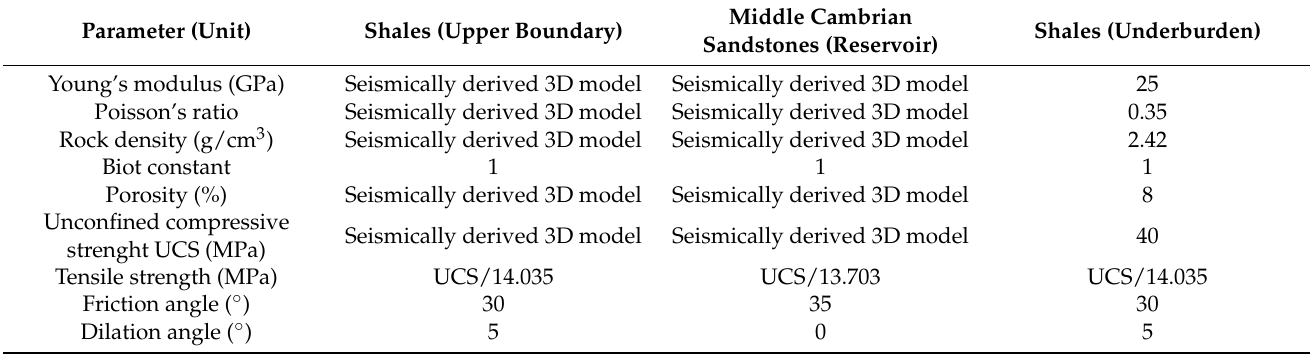
Table 4. Assumed values of elastic and strength properties for the isotropic medium and surrounding rocks [50–54]. Parameter (Unit)